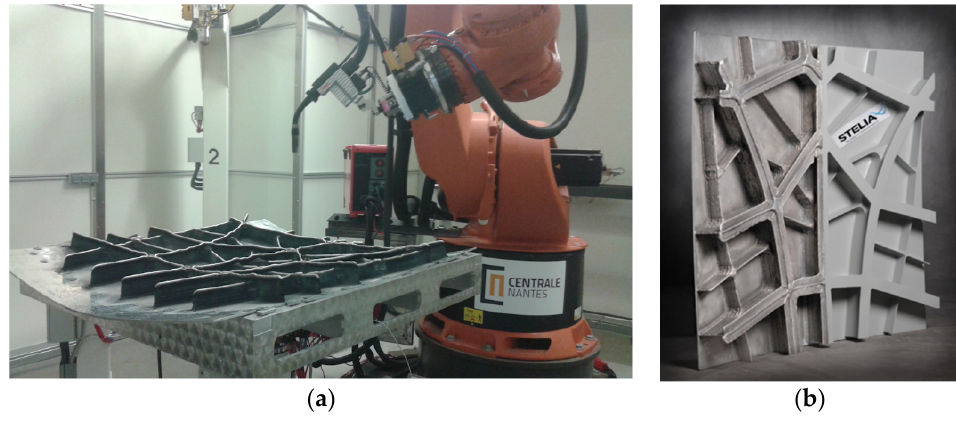
Figure 14. Structural panel: ( a ) during the manufacturing process and ( b ) finished.